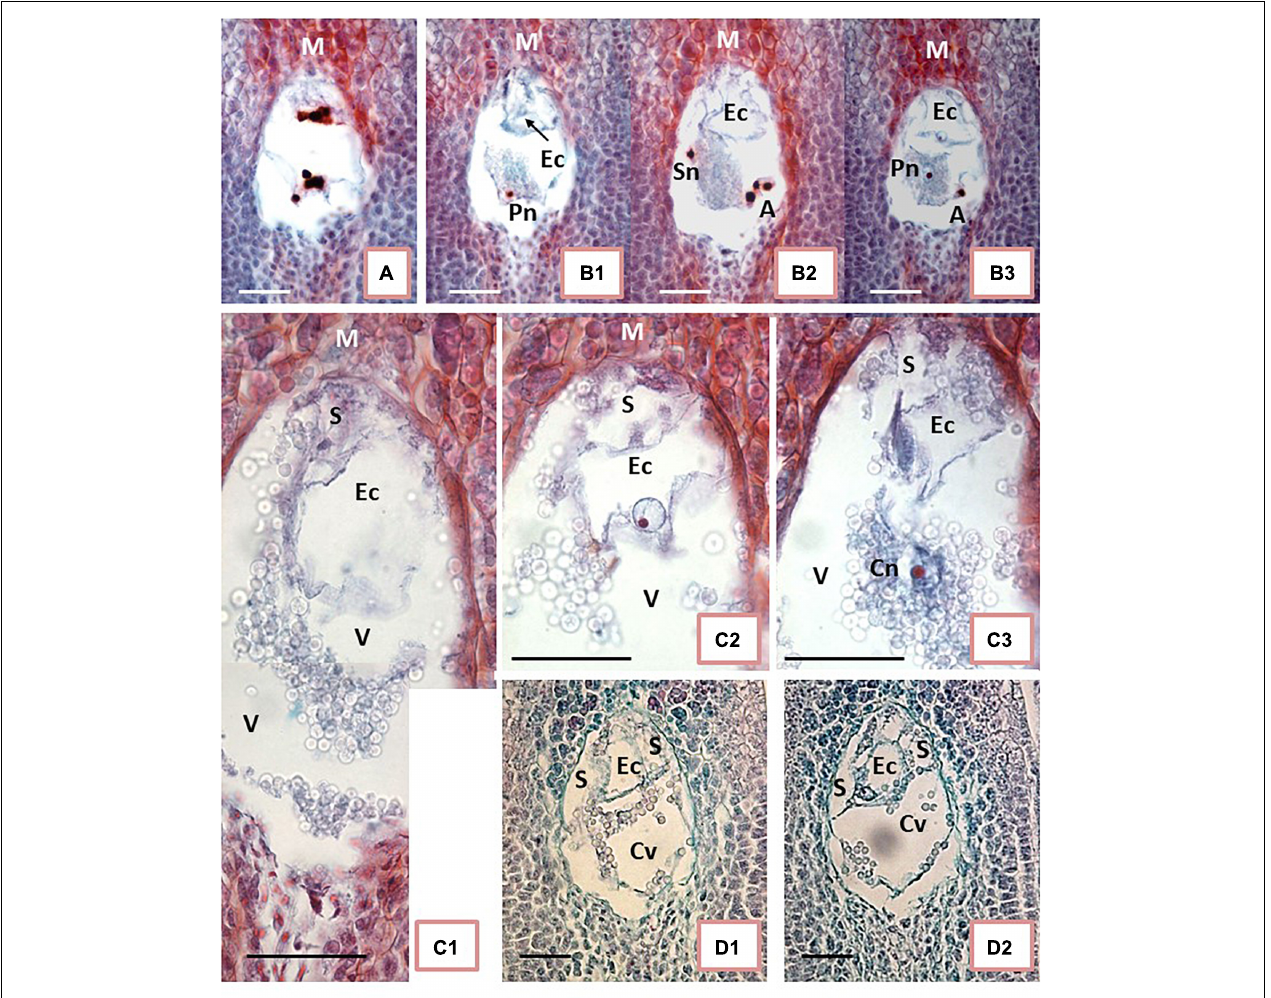
FIGURE 2 | Embryo sac development of unpollinated ovules. (A,B) On the day of anthesis (Day 0, the day of the first opening of bracts). (C) One day after anthesis (1 DAA). (D) 2 DAA. (A) Shows 8-nucleate embryo sac (ES). At the micropylar (M) end (top end of ES in the picture), the nuclei are in late anaphase-telophase stage. The nuclei at the chalazal end of ES already completed divisions. (B1–B3) Show ES during cellular organization. Synergids are not yet formed. One of the potential synergid nucleus is visible on (B2) close to the left ES wall. An outline of the egg cell (Ec) is visible at the M end on (B1–B3) . Outline of the Ec is visible in each picture, whereas the Ec nucleus is visible on (B3) exclusively. (B2) Shows a group of three nuclei in the lower right corner (putative antipodals), and (B3) shows a cut-off fragment of one nucleus at the corresponding position. Two polar nuclei are visible separately and at a distance: the first one in the bottom-left corner of ES (B1) near a central starch clump, and the second one in the middle of starch grains, close to the ES center (B3) . (C1–C3) Correspond to three sections in sequence showing fragments of ES. The highly vacuolated Ec is visible at the M end. The basal end of Ec is attached eccentrically to the ES wall, slightly to the right of its top (C1–C3) . The Ec nucleus is visible only in (C2) . A fragment of the synergid is visible above Ec to the left. The second synergid is not visible on the presented sections. Either a polar nucleus or the polar nuclei already fused into the secondary nucleus of the central cell of ES are visible in C3. (D1,D2) show further EC apparatus organization; two synergids are visible on both sides of Ec. (A,B,D) present photos taken with 40x objective while (C) had an objective of 100x. Bar = 20 µ m. (Ec) egg cell; (S) synergid cell; (Sn) synergid nucleus; (A) antipodal cells; (Pn) polar cell nucleus; (Cn) central cell nucleus; (V) vacuole; (Cv) central cell